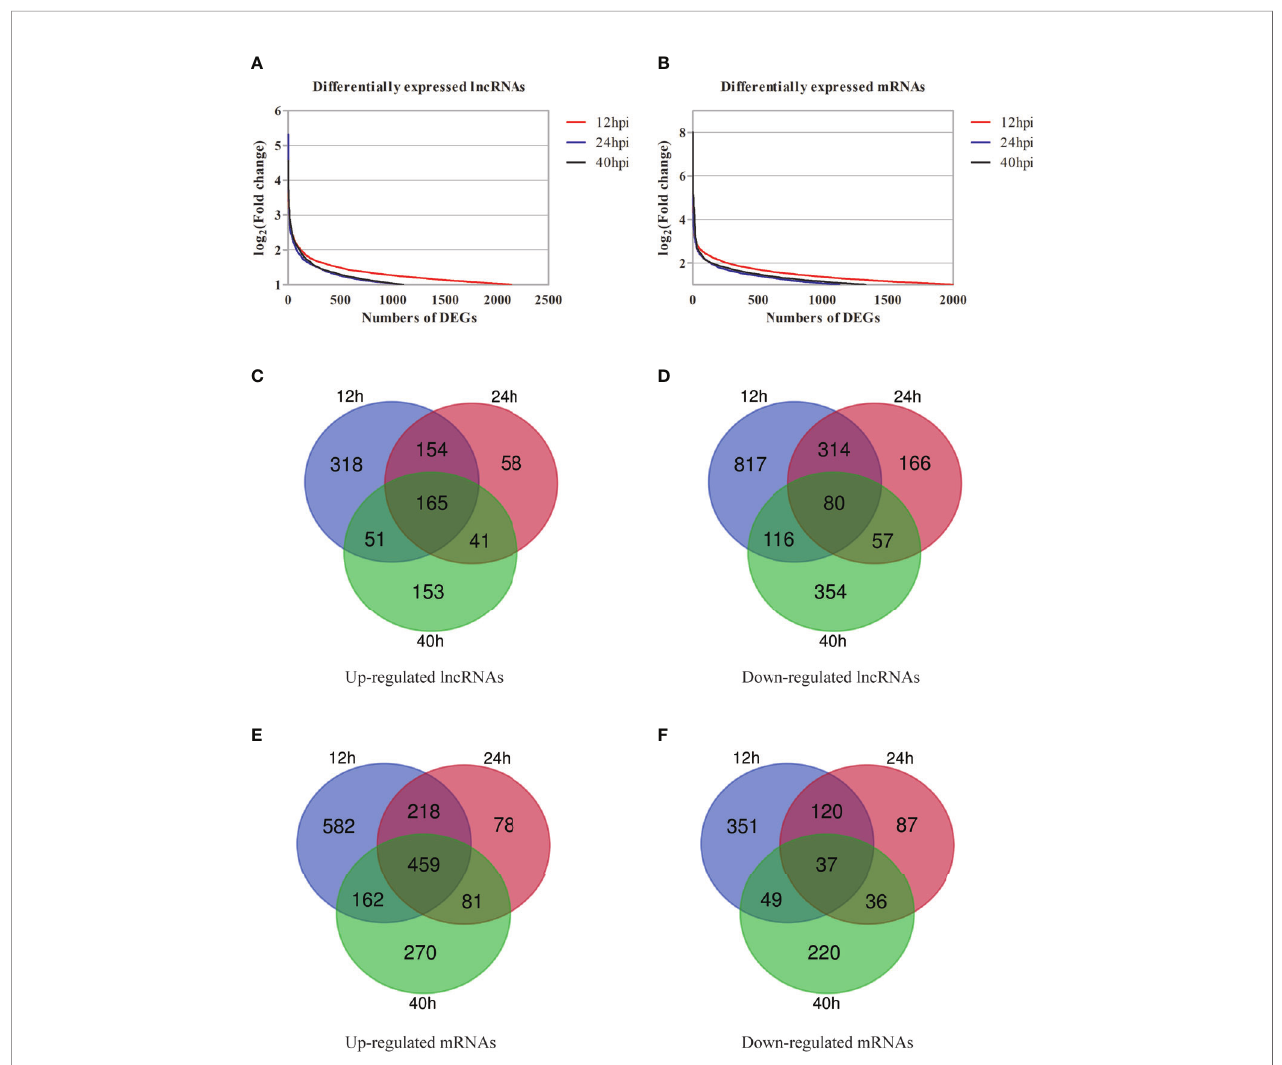
FIGURE 3 | Preliminary overview of DGs at different post-infected hours. (A, B) The distribution of differentially expressed lncRNAs (A) and differentially expressed mRNAs (B) at different post-infected hours shown by scatter plots. (C, D) Venn diagrams indicate the numbers of overlapping and non-overlapping upregulated lncRNAs (C) and downregulated lncRNAs (D) . (E, F) Venn diagrams indicate the numbers of overlapping and non-overlapping up-regulated mRNAs (E) and downregulated mRNAs (F)